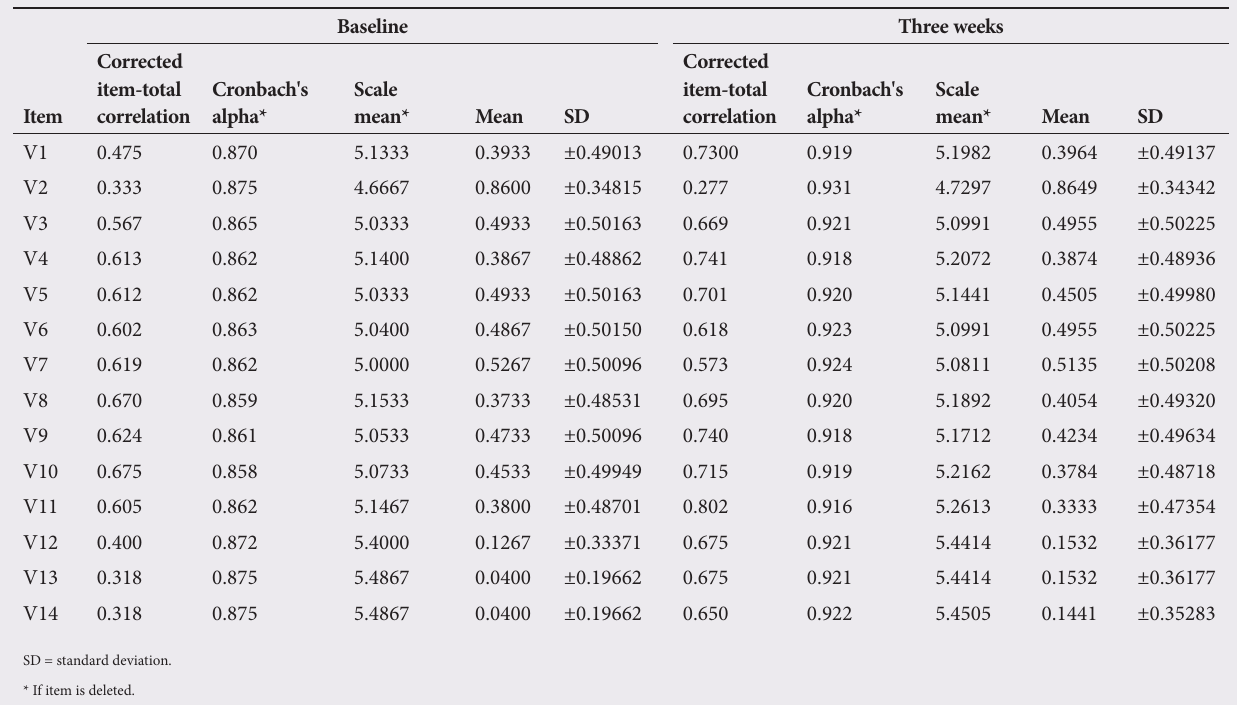
Table 3. Corrected item-total